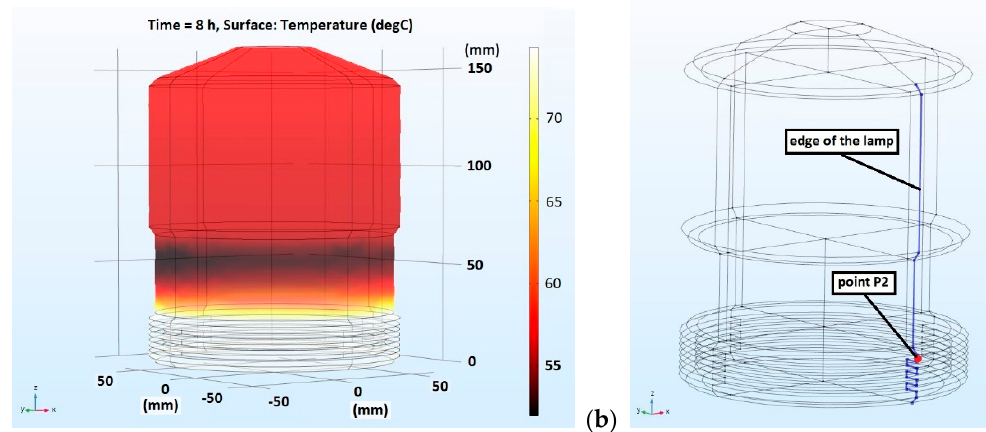
Figure 4. ( a ) Example image from simulation result depicting temperature distribution at the surface of the lamp in the steady state; ( b ) location on the edge of the lamp and at point P2 in the computational domain.